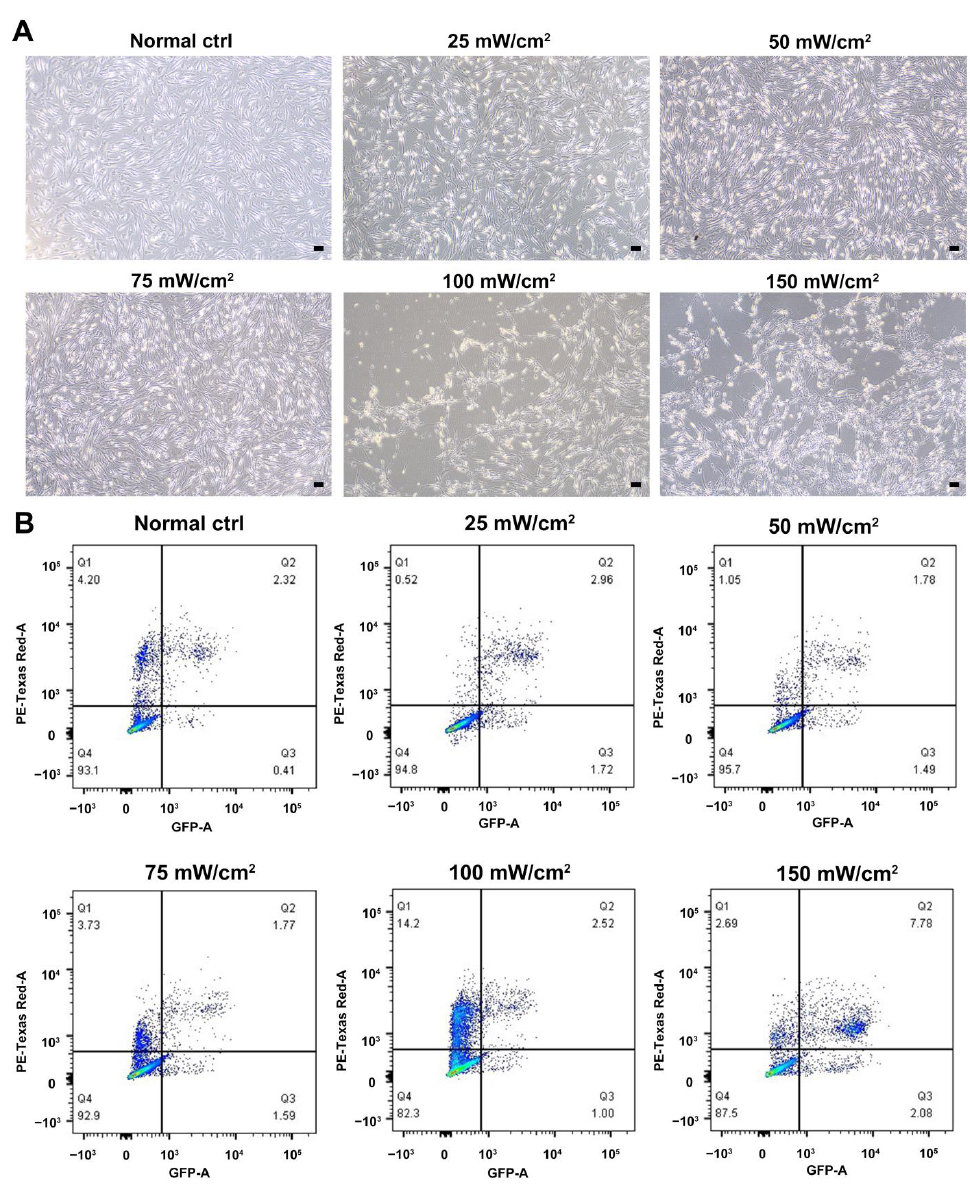
Figure 2. Biosafety assessment of LIPUS. LIPUS of different intensities was applied to LCs to evaluate its biosafety. The results of light microscope observation ( A ) and Annexin-V and PI staining and flow cytometry ( B ) demonstrated that 100mW/cm 2 and 150 mW/cm 2 LIPUS will cause more apoptosis to LCs. The scale bar represents 100 µ